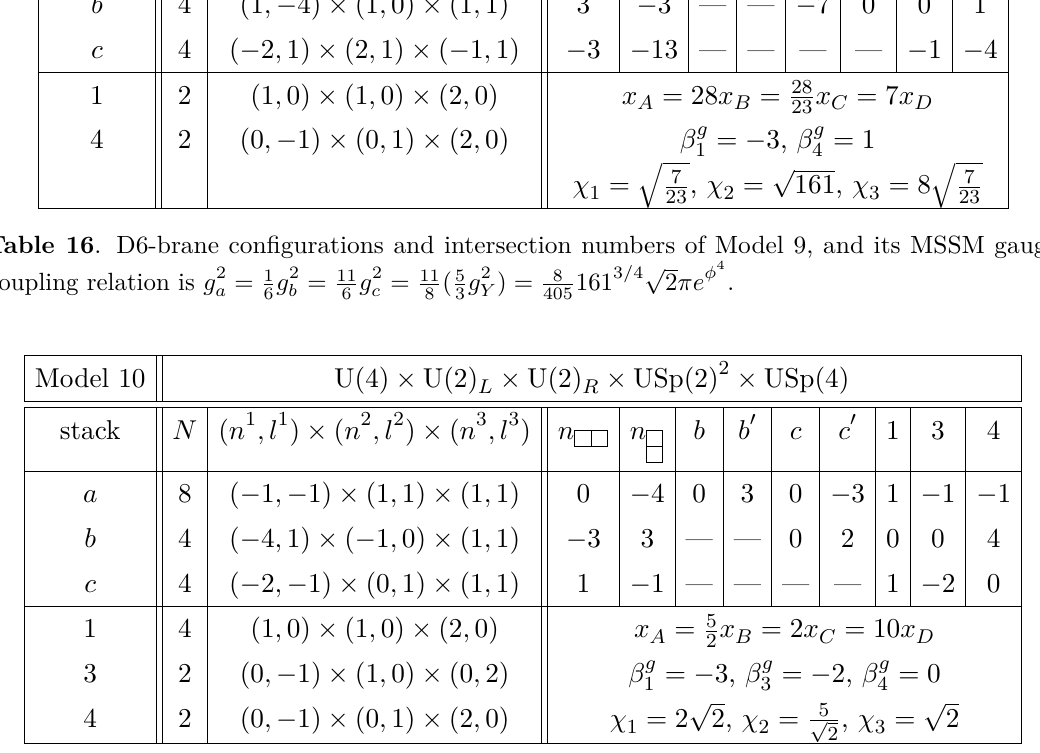
Table 17 . D6-brane configurations and intersection numbers of Model 10, and its MSSM gauge